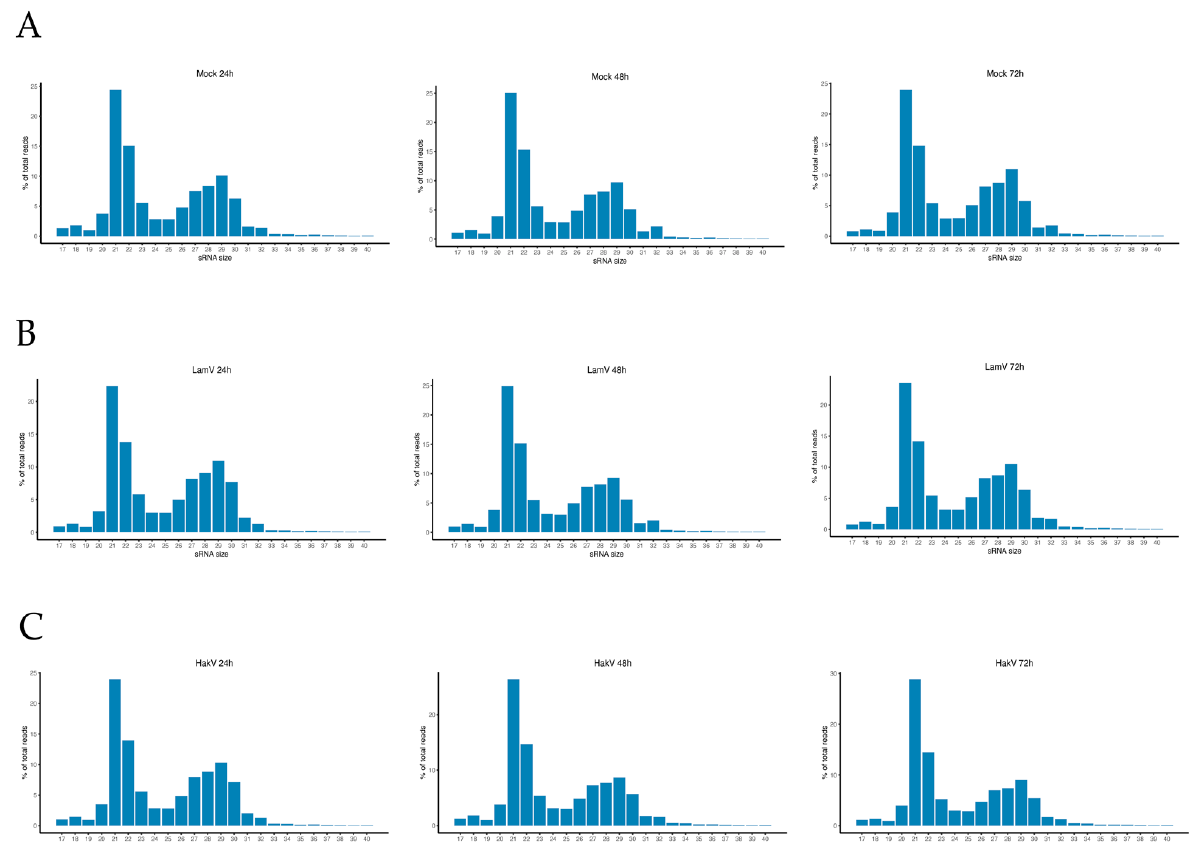
Figure 1. Small RNA profiles of U4.4 cells at 24, 48, and 72 h. ( A ) Small RNA profile of total reads in mock infected cells; ( B ) small RNA profile of total read in LamV-infected cells; ( C ) small RNA profile of total reads in HakV-infected cells. To confirm active viral infection and replication, the supernatant was collected, further processed by RNA extraction and cDNA synthesis, and analyzed with qPCR. The data were used to calculate a growth curve over time (Figure 2). Both LamV and HakV showed steep virus growth during the first 48 h before plateauing. Furthermore, LamV showed a higher replication compared to HakV, with approximately one log more RNA copies at 48 h p.i. and the later timepoints recorded (Figure 2).